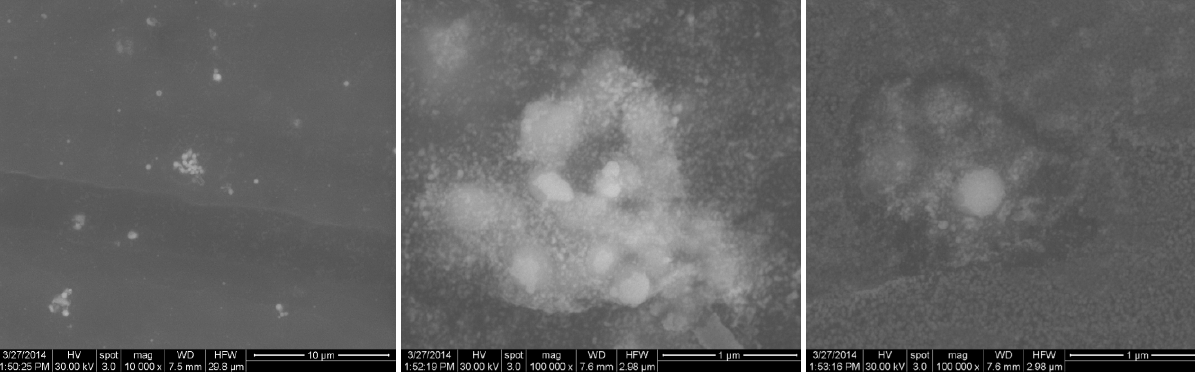
Figure 7. Backscattered electron image ofFe